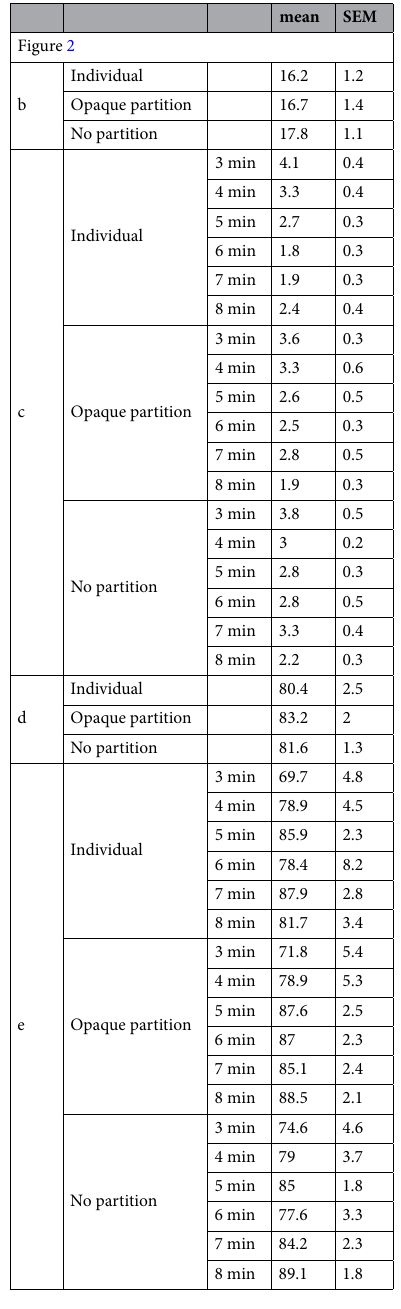
Table 1. Mean and SEM for Fig.